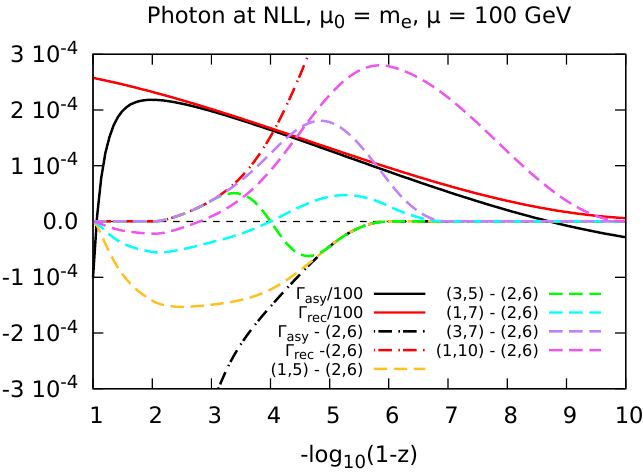
Figure 4 . Study of the dependence of the matched photon PDF upon the parameters of the matching function G ( z ), de(cid:12)ned in eq. (7.25). We have set (cid:22) = 100